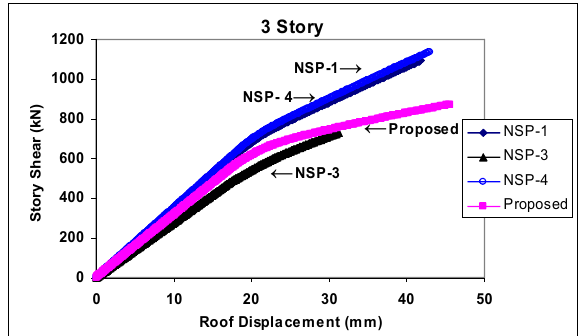
/H=cte top /H=cte top